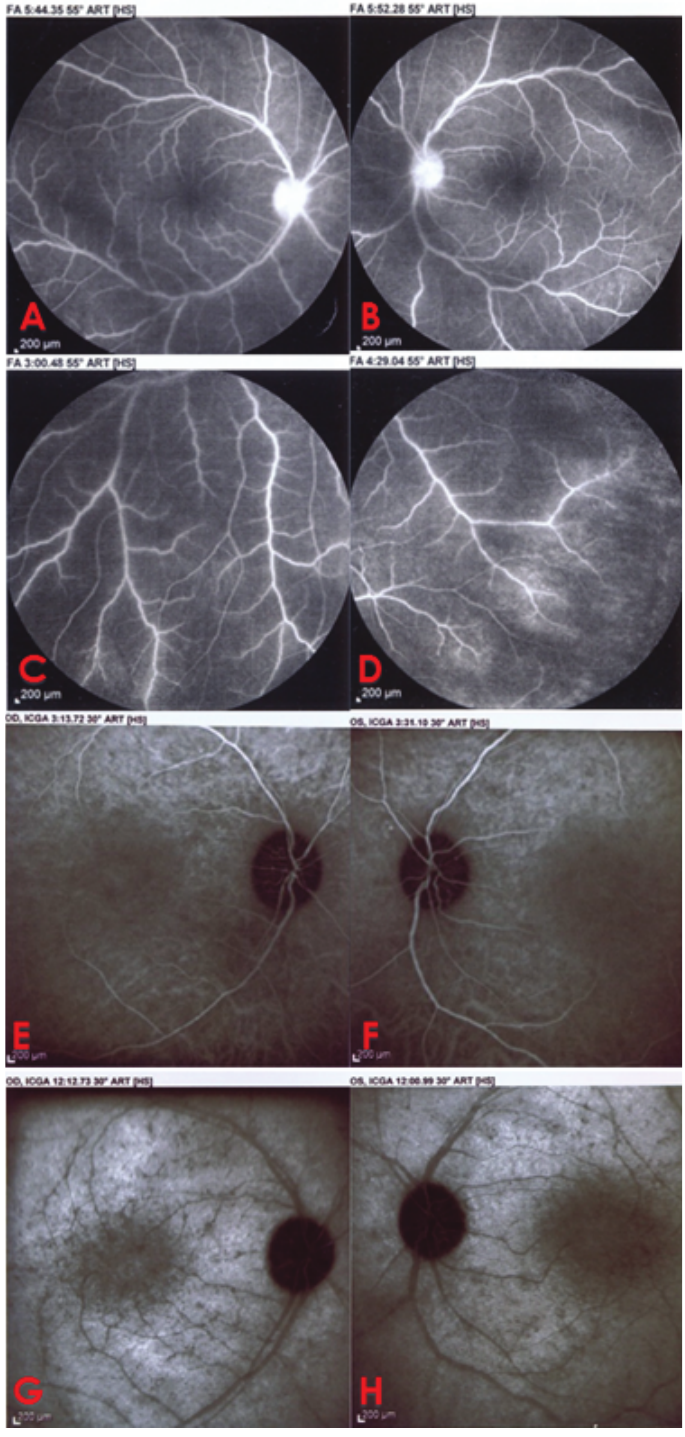
Figure 2. (A & B) Disc hyperfluorescence is seen on fluorescein angiography. (C & D) Mild vascular leakage (almost from veins) is more prominent at retinal mid-periphery on fluorescein angiography. (E–H) Indocyanine green angiography shows multiple hypocyanescent spots in late